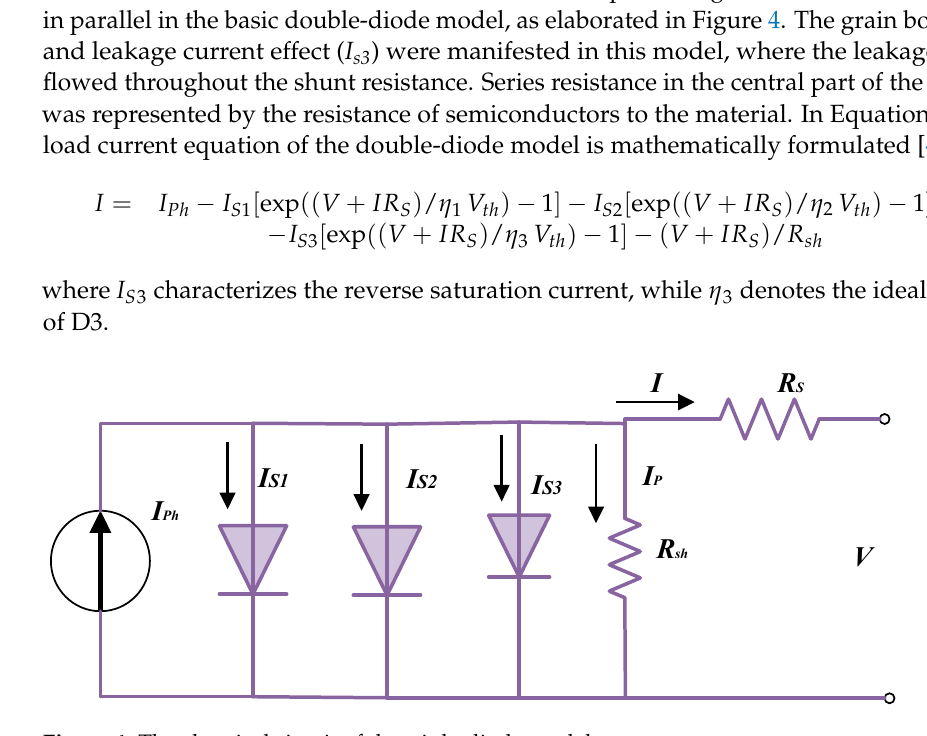
Figure 4. The electrical circuit of the triple-diode model.